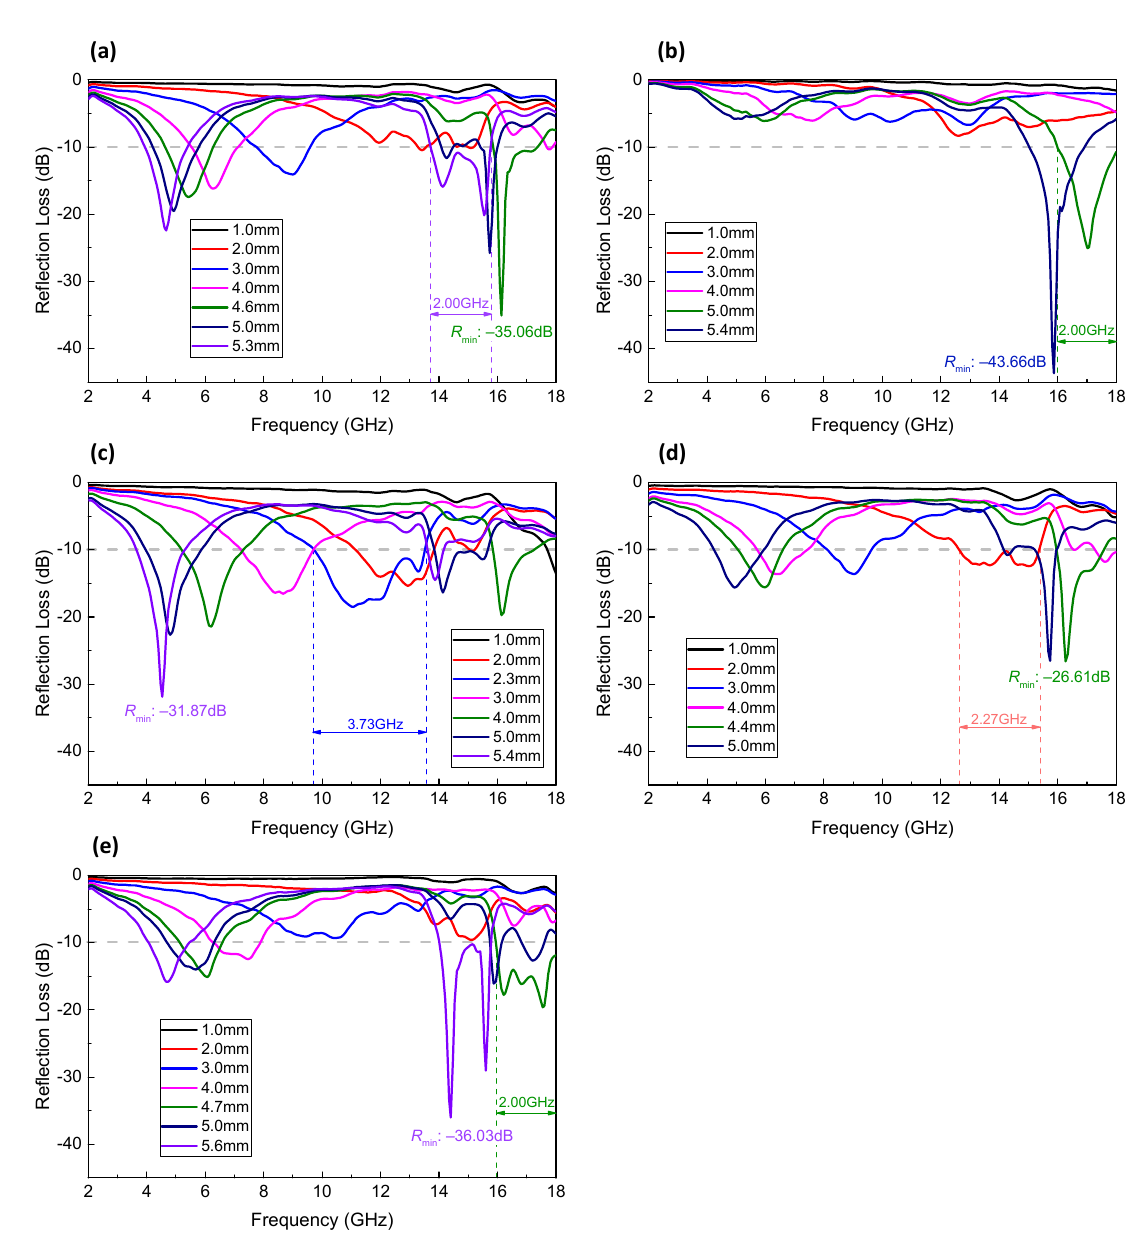
Figure 12. Reflection loss (R) of ( a ) Fe nanowires, ( b ) Fe@PANI-95/5, ( c ) Fe@PANI-90/10, ( d ) Fe@PANI-80/20, and ( e ) Fe@PANI-70/30 with different thicknesses. Fe NW with a thickness of 4.6 mm (green curve) exhibited the lowest reflection loss of − 35.06 dB (absorption e ffi ciency 99.97%) at 16.13 GHz. For a thickness of 5.3 mm, it possessed a maximum effective absorption bandwidth of 2 GHz (13.6–15.6 GHz). Figure